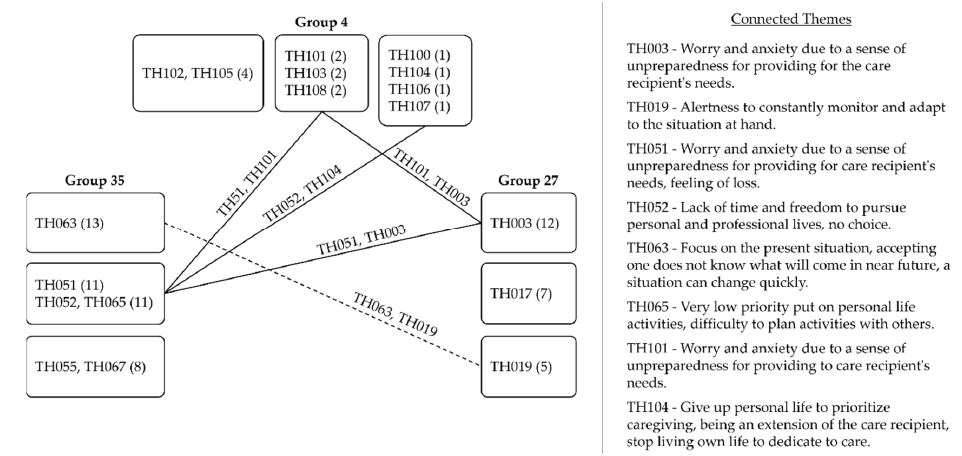
Figure 2. Network of themes in experience.